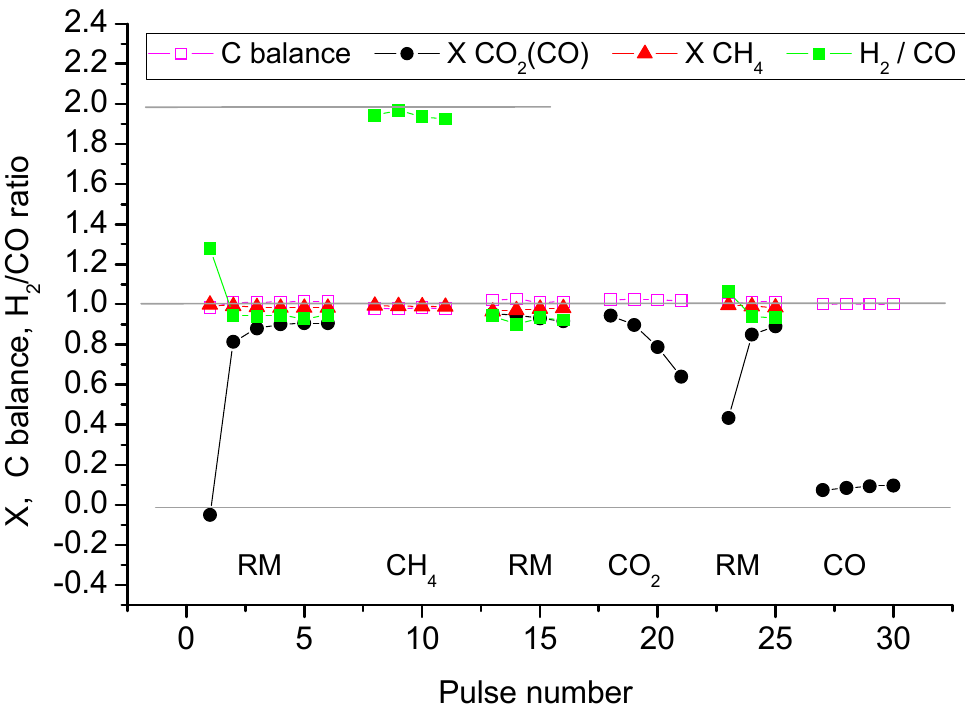
Figure 1. Conversions of reagents and products characteristics in series of pulses at 973 K.